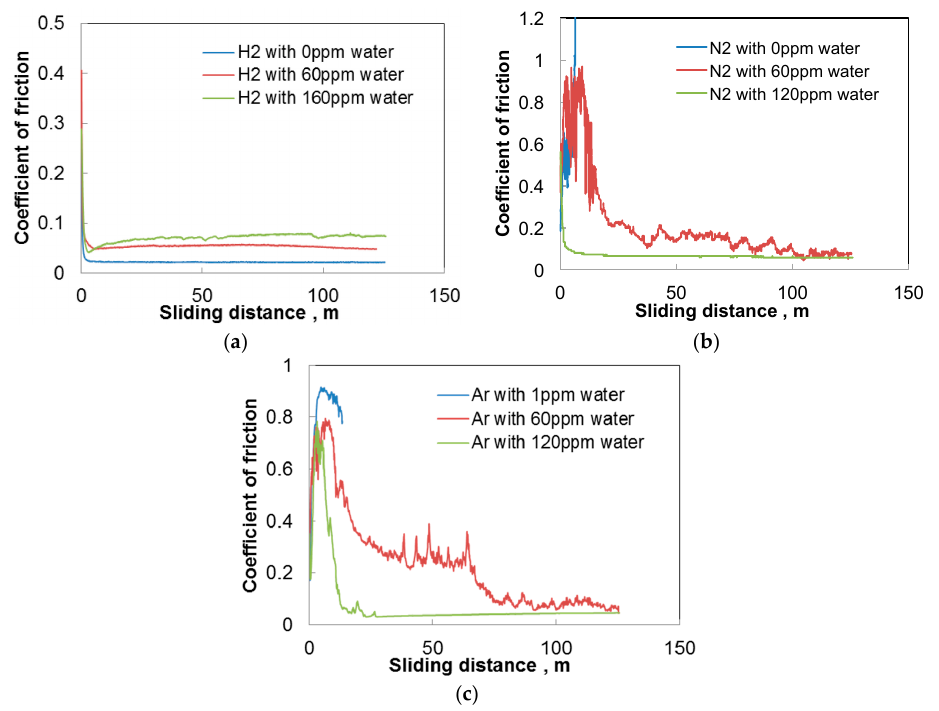
Figure 2. Changes in the coefficient of friction with sliding distance; a-C:H DLC disk and aluminum pin; ( a ) in hydrogen; ( b ) in nitrogen; and ( c ) in argon.